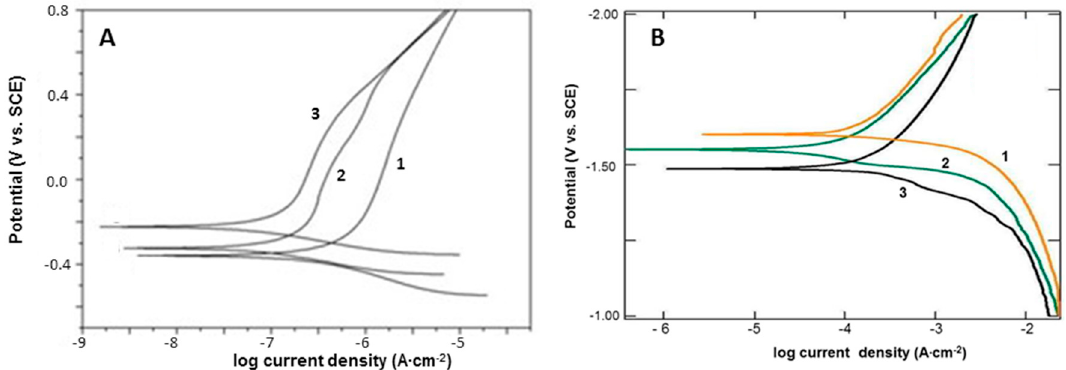
Figure 7. ( A ) Potentiodynamic polarization curves of uncoated Ti6Al4V alloy (1), Ti6Al4V sol-gel coated with hydroxylapatite (2), and Ti6Al4V dip-coated with a hydroxylapatite/poly( ε -caprolactone) composite coating (3). ( B ) Potentiodynamic polarization curves of uncoated biodegradable WE43 Mg alloy (1), WE43 Mg alloy electrophoretically (2), and pulsed laser deposition (3) coated with hydroxylapatite [62]. For explanation, see text. © With permission by Elsevier.